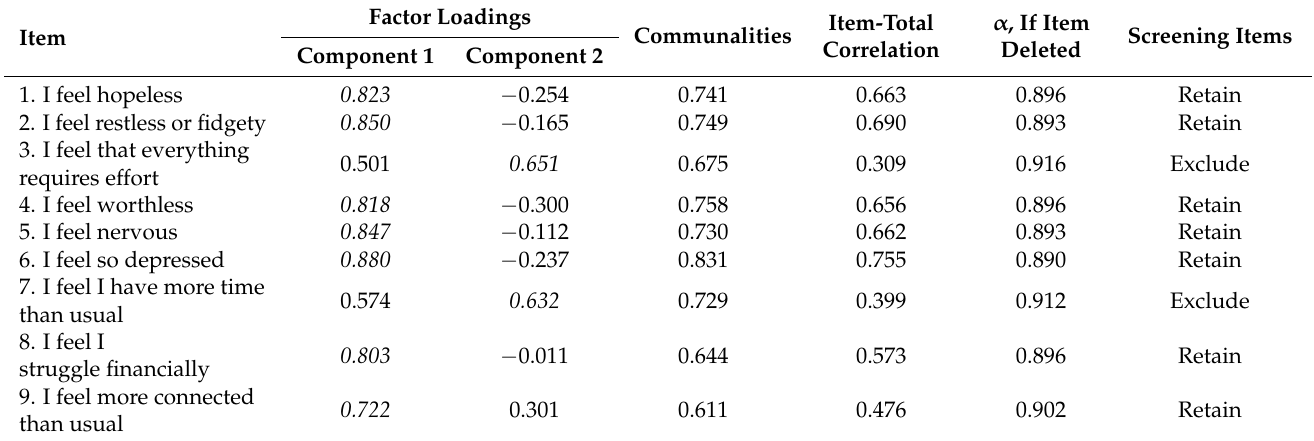
Table A1. Earlier factor analysis of C-ESES with factor loading and item—total correlation results.